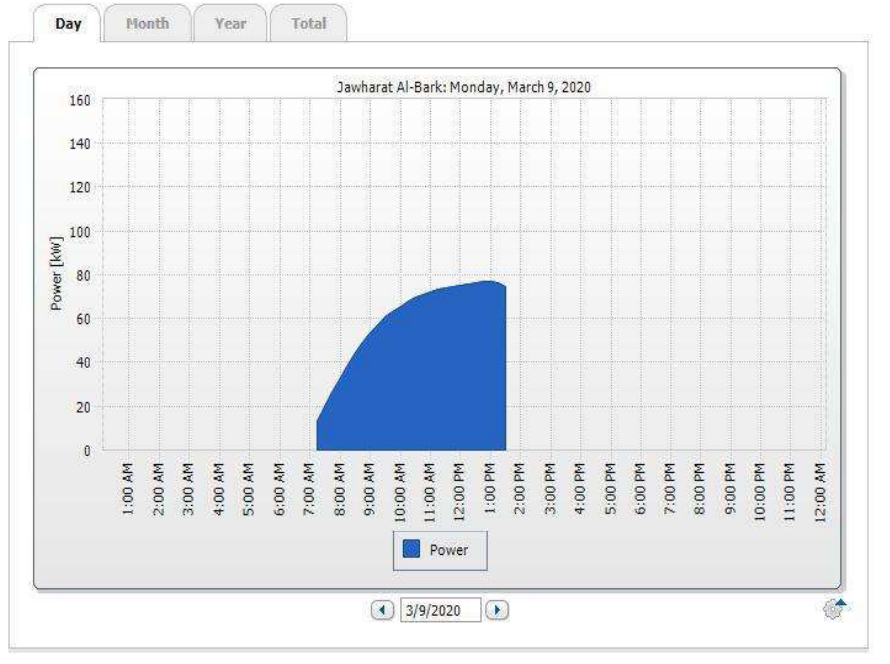
Figure 9. Actual yield of PV system in REERC